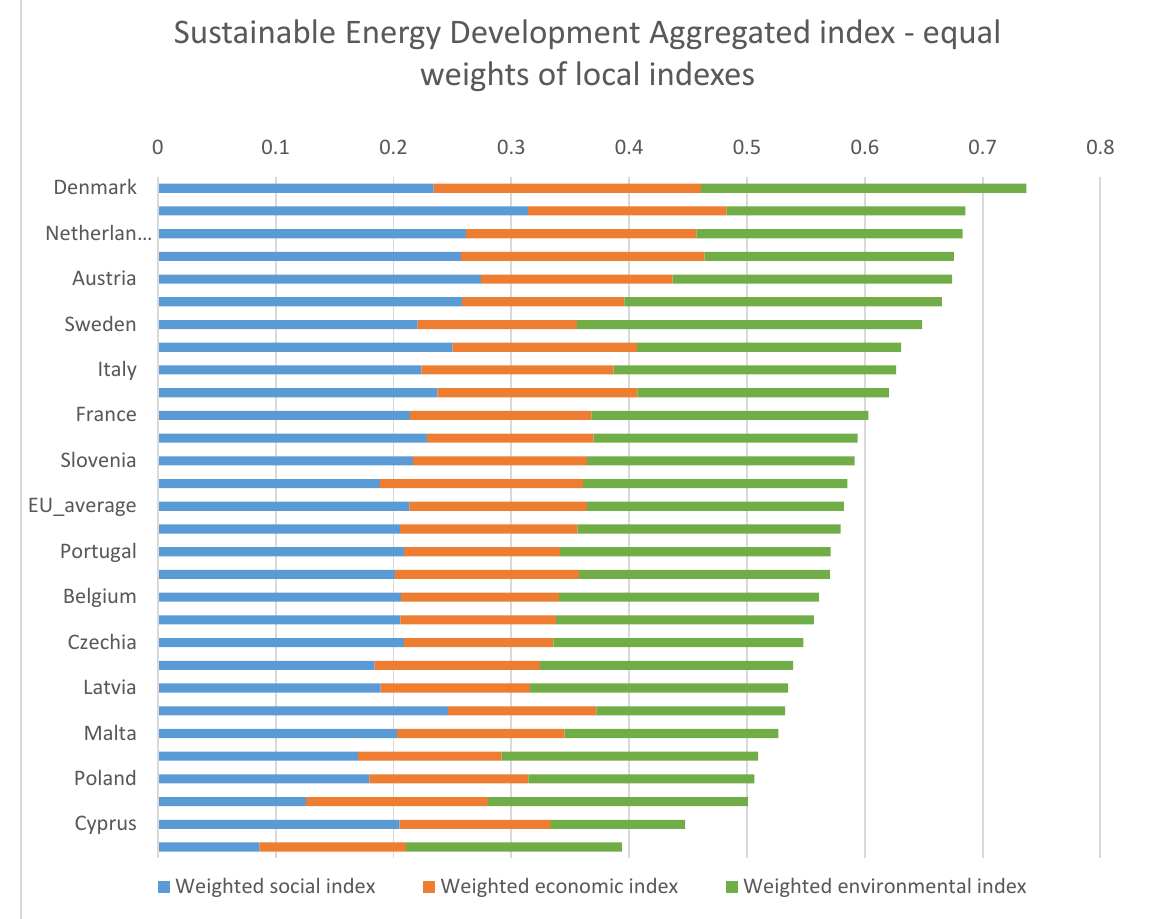
Figure 4. Sustainable Energy Development Aggregated Index (SEDAI) in 2017 for the EU-28 Member States.